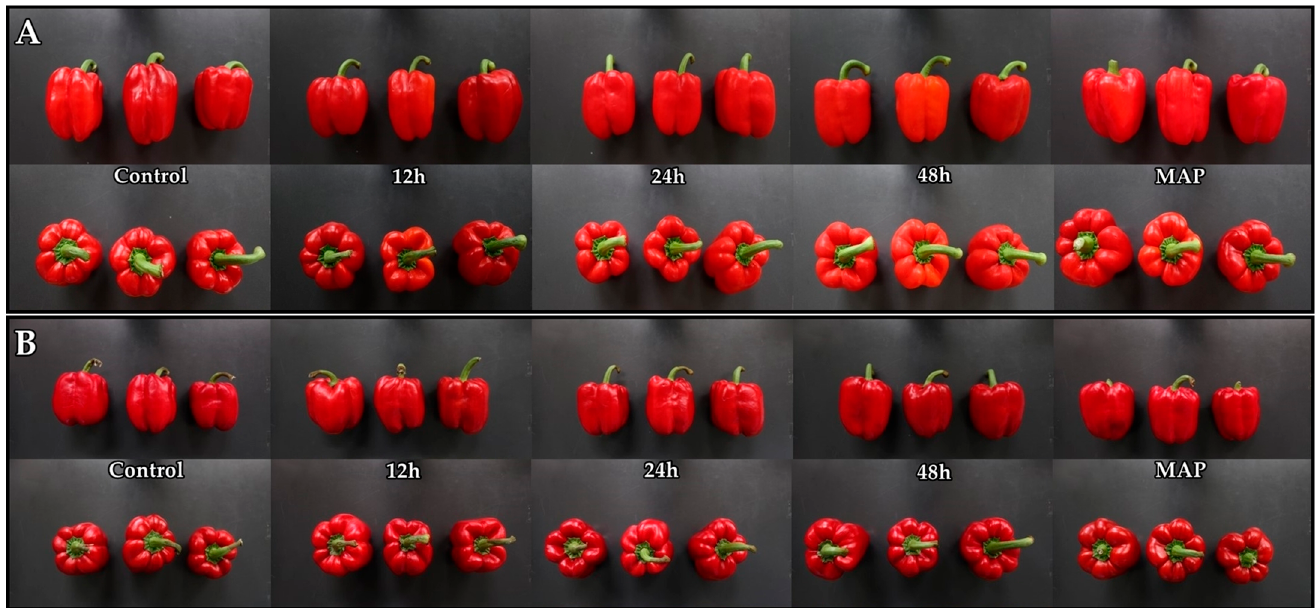
Figure 3. Image of sweet pepper fruits pretreated with 10% CO 2 for 12, 24, and 48 h, as well as untreated and modified atmosphere packaging (MAP) with 50,000 cc ∙ m − 2 ∙ day − 1 ∙ atm − 1 OTR film on